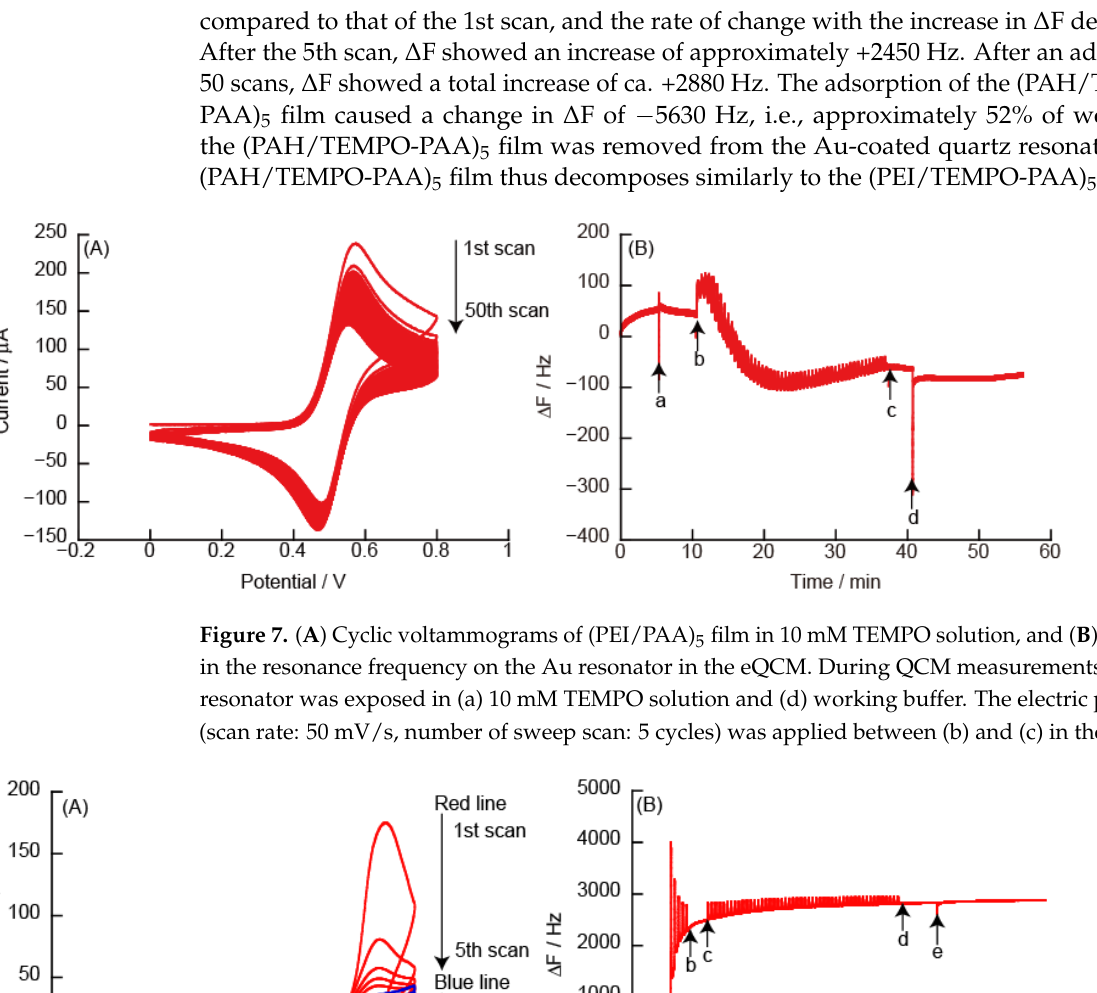
Figure 7. ( A ) Cyclic voltammograms of (PEI/ PAA) 5 film in 10 mM TEMPO solution, and ( B ) changes in the resonance frequency on the Au resonator in the eQCM. During QCM measurements, the Au resonator was exposed in (a) 10 mM TEMPO solution and (d) working buffer. The electric potential (scan rate: 50 mV/s, number of sweep scan: 5 cycles) was applied between (b) and (c) in the eQCM.